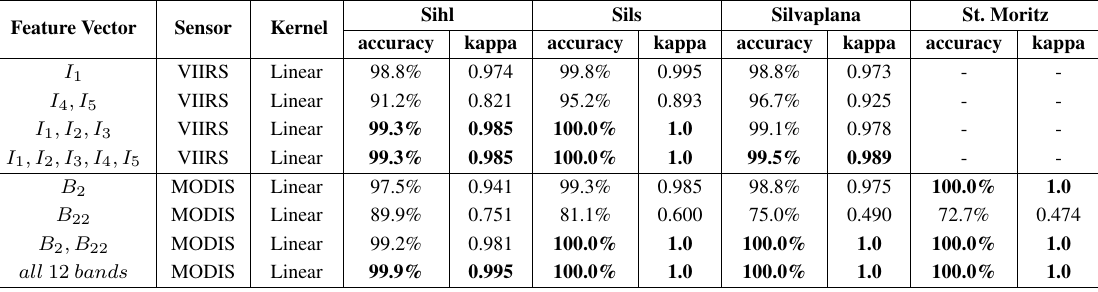
Table 7: Results from 2016 - 17 for both VIIRS and MODIS data: Comparison of 4 -fold cross-validated SVM results with different channel combinations as feature vector. The overall accuracy and kappa coefficients are both given.